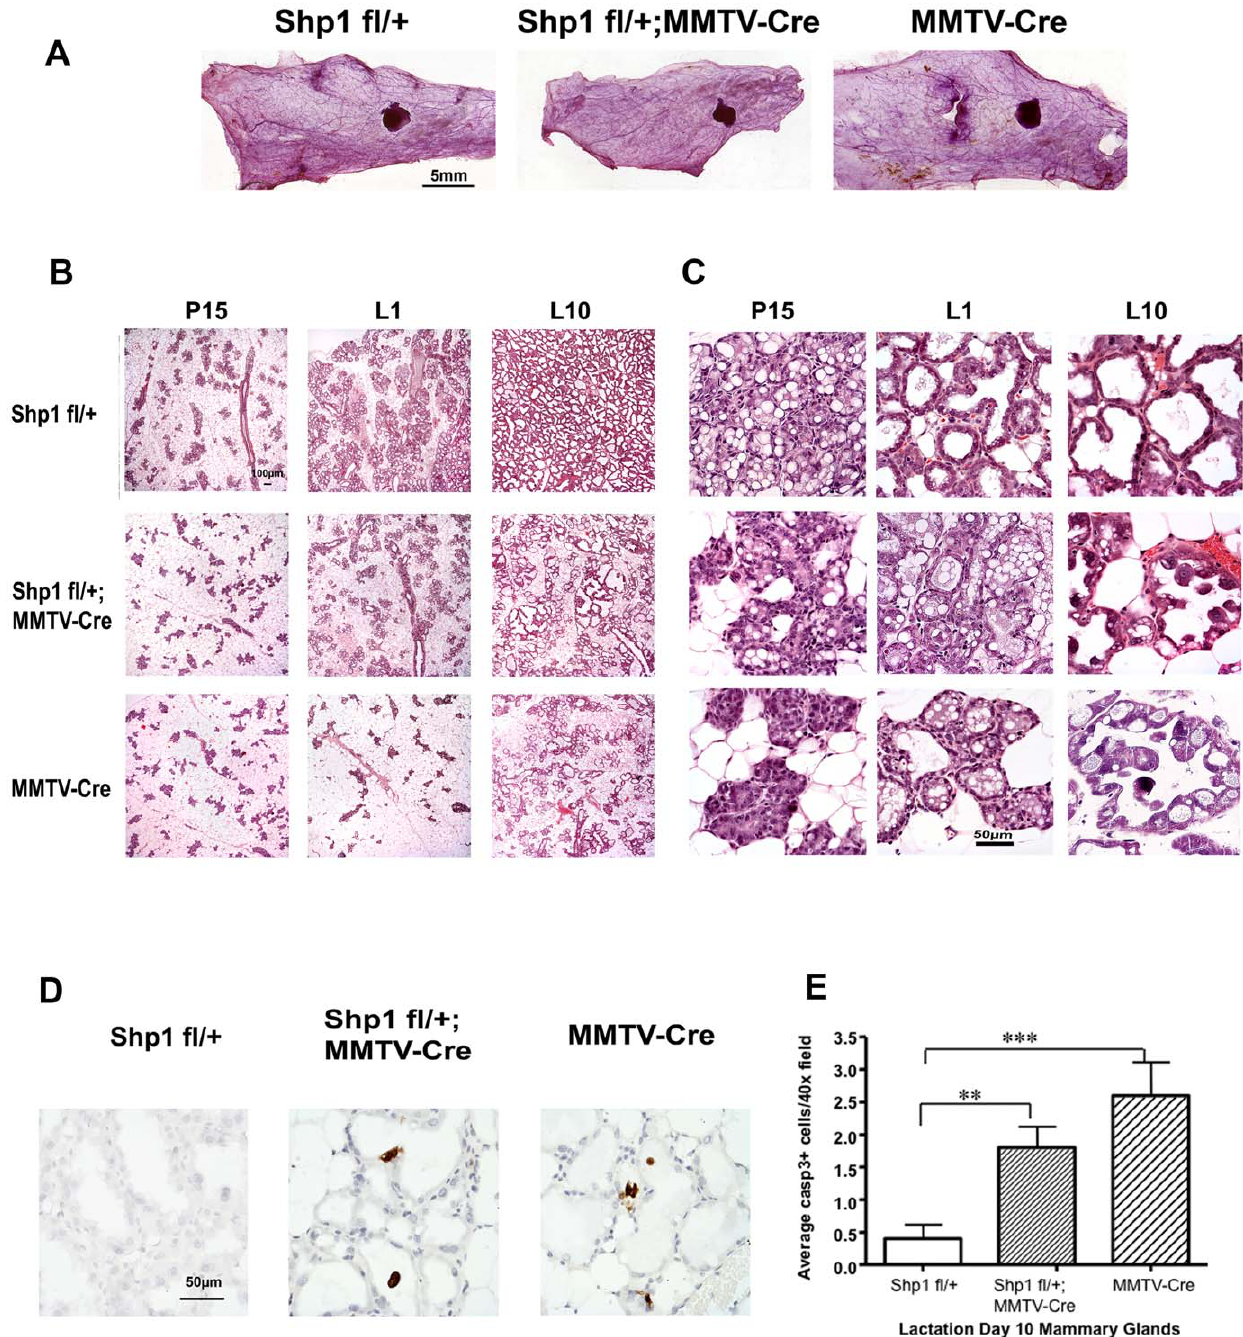
Figure 2. Impaired differentiation and precocious involution of mammary epithelial cells in mice expressing the MMTV-Cre transgene. (A) The number 4 mammary glands from Shp1 fl/ + (control), Shp1 fl/ + /;MMTV-Cre, and MMTV-Cre mice were isolated from 10-week old virgin mice and subjected to whole mount analysis as described in the Materials and Methods. Scale bar=5 mm. (B, C) Six-week old Shp1 fl/ + (control), Shp1 fl/ + ;MMTV-Cre, and MMTV-Cre female mice were mated with male wild type mice. The number 4 mammary glands were removed at pregnancy day 15 (P15), lactation day 1 (L1), and day 10 (L10), and processed for histological analysis as described in the Materials and Methods. Images were taken under lower (B) and higher (C) magnification respectively. Scale bars represent 100 m m in (B) and 50 m m in (C). Similar results were seen from at least two different mice for each genotype. (D, E) Analysis of apoptotic cells in L10 mammary glands as described in (B, C). (D) Sections of L10 mammary glands from indicated mice were stained with antibody against cleaved caspase 3 (see Materials and Methods). Cells positive for cleaved caspase 3 are stained dark-brown. Images were taken using 40X objective lens. Scale bar=50 m m. (E) Quantification of caspase 3 positive cells from (D) (see Materials and Methods). Two mice from each genotype were analyzed. **p , 0.01 and ***p , 0.001.